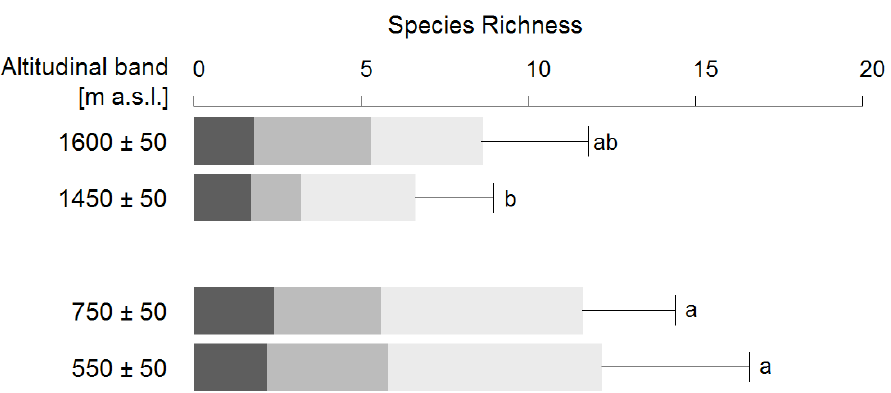
Figure 4. Cumulative mean species richness for mosses (dark grey), herbaceous (grey), and woody plants (light grey) per altitudinal band. Error bars refer to total species richness showing its standard deviation. Lower case letters indicate significant differences in total species richness (Tukey HSD, p <